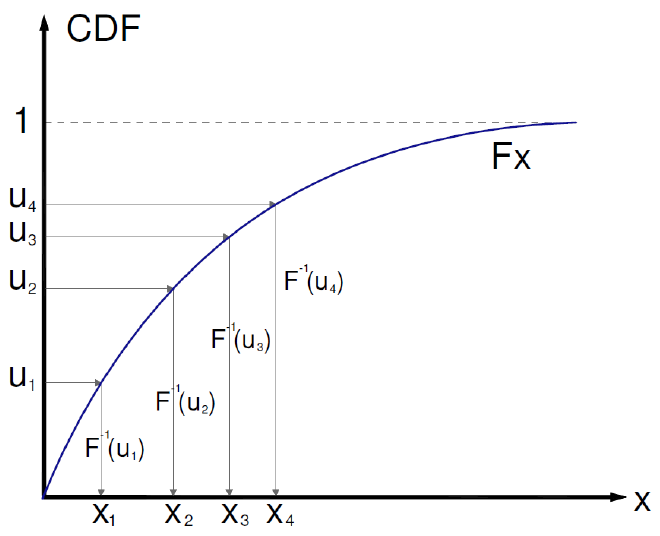
Figure 6. Inverse transform sampling.